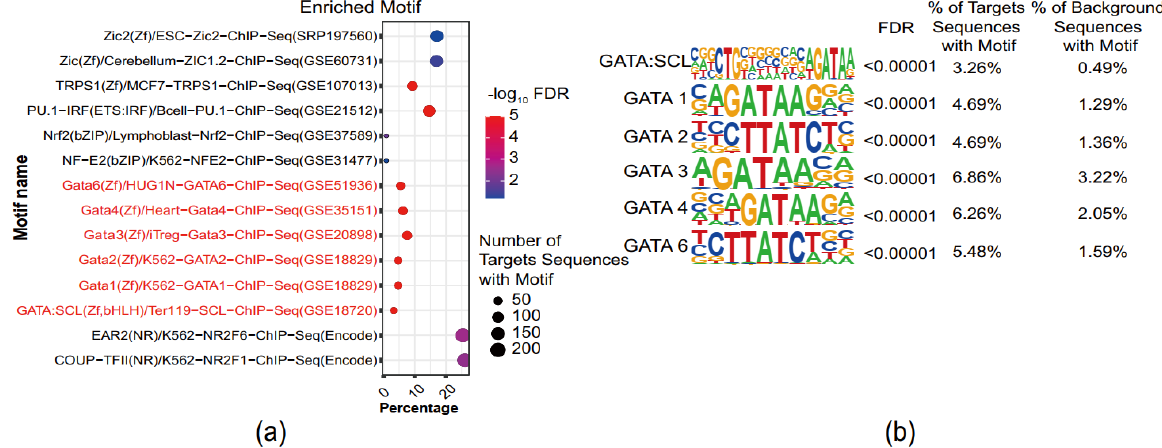
Figure 3. GATA-binding motifs are enriched in superimposed PE ( a ) The enriched motifs. The analysis was conducted by HOMER with parameters set to ‘find regulatory element’. ( b ) The enriched GATA family motifs.